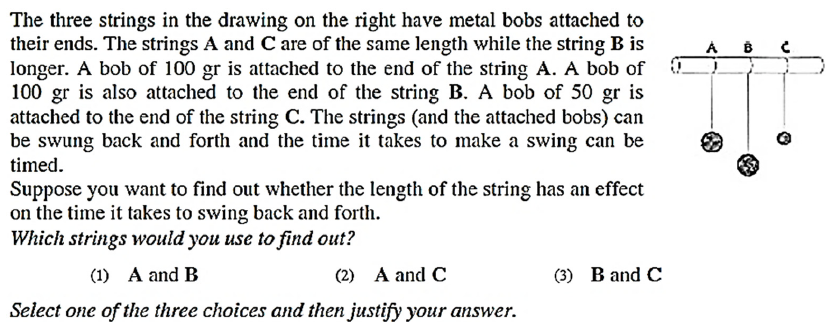
Figure A2. Sample item from the Logical Thinking test..